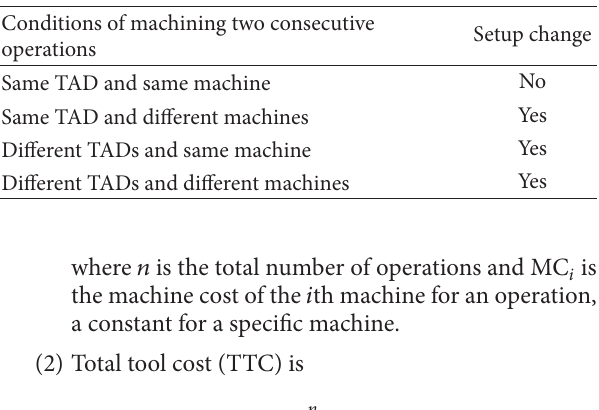
Table 4: Definition of a setup